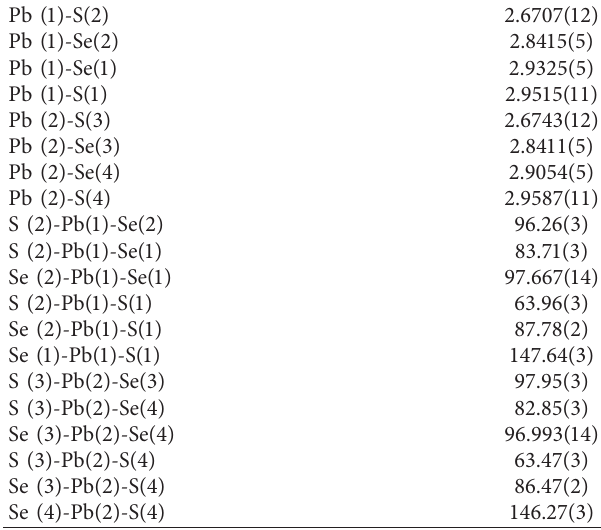
Table 2: Selected bond lengths (˚A) and angles ( ° ) for the